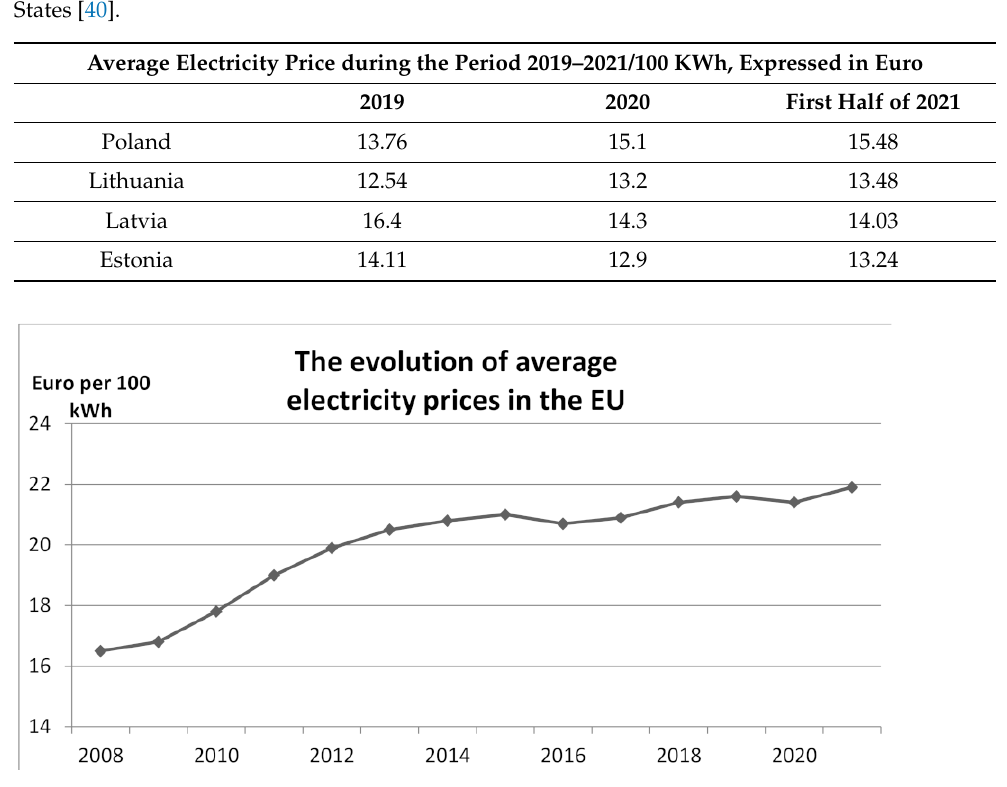
Table 2. Changes in average electricity prices per 100 KWh in 2019–2021 in Poland and the Baltic States [40].